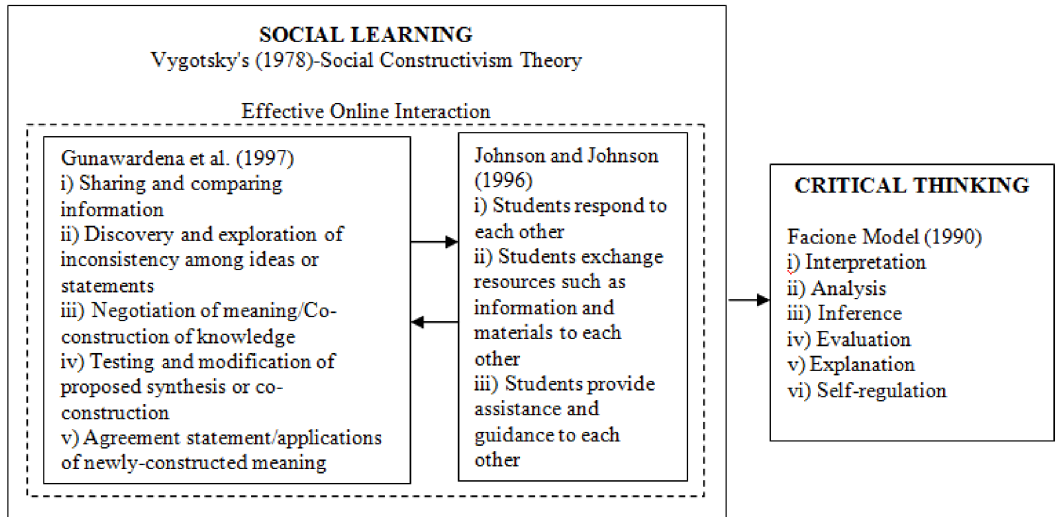
Figure 4. The framework of online interaction in social learning to promote critical